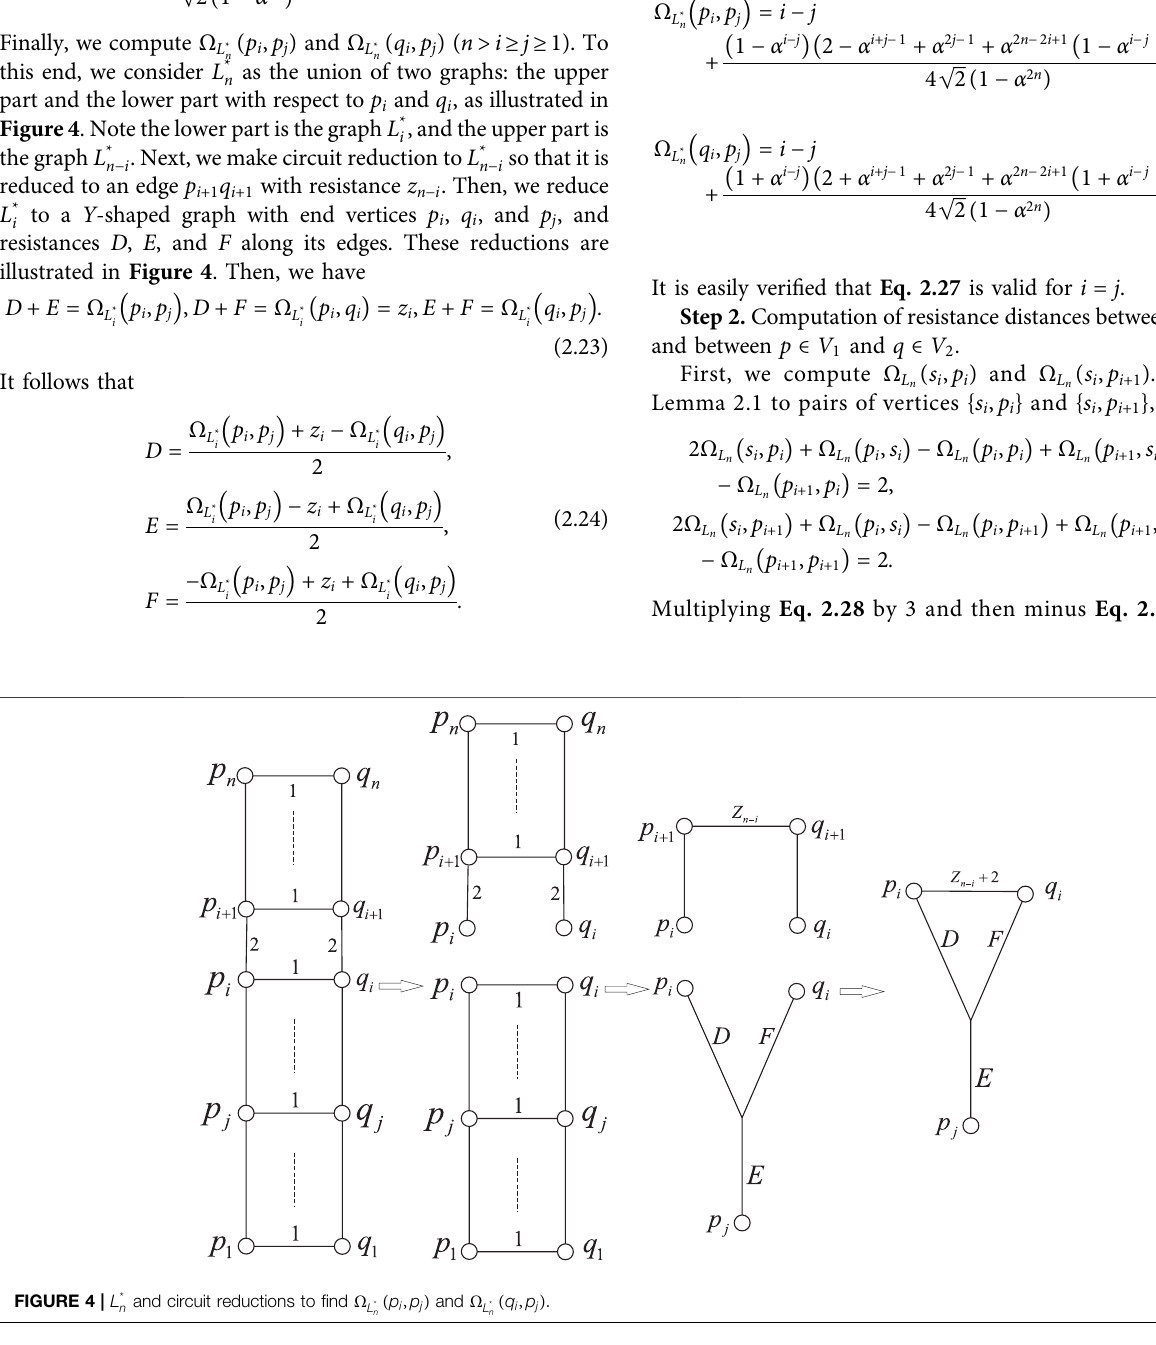
Frontiers in Physics |